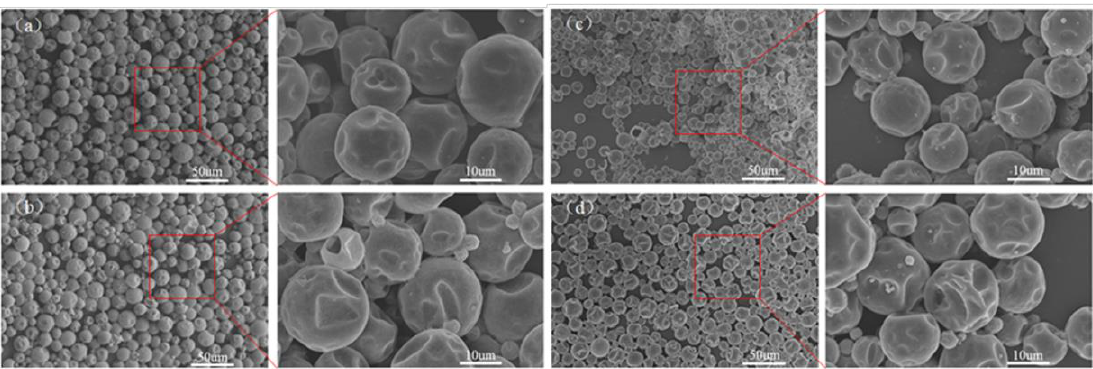
Figure 4. Influence of various addition amounts of TEOS on morphology of polyurethane MicroPCMs: ( a ) 0 g; ( b ) 2 g; ( c ) 4 g; and ( d ) 6 g.